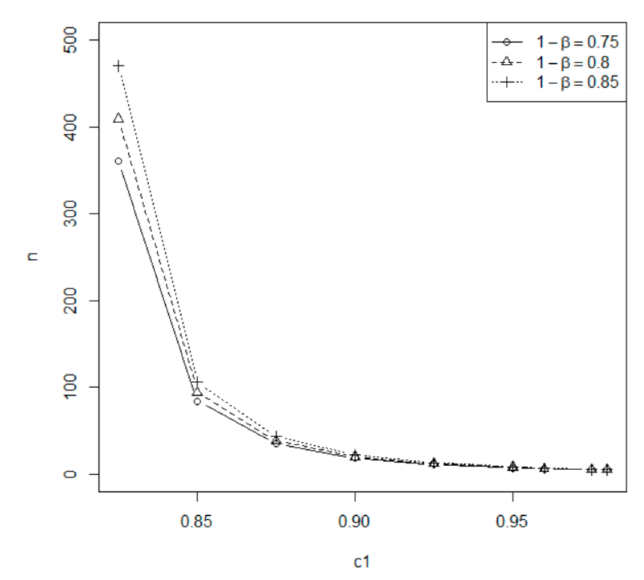
Figure 1. Minimum sample size for the test at α = 0.05, p = 0.05, and m =